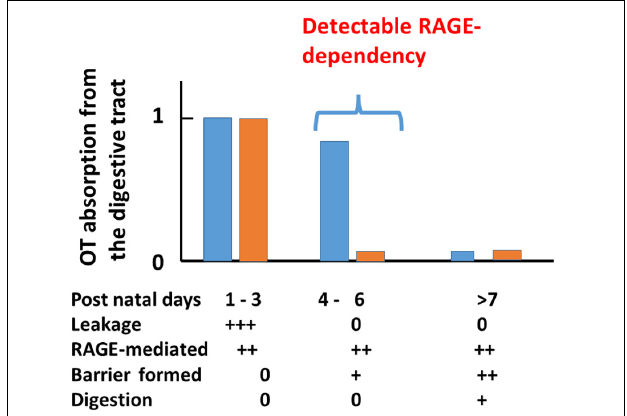
FIGURE 2 | A scheme for plasma OT (OT) concentrations in wild-type (blue) and receptor for advanced glycation end-product (RAGE) knockout (KO; orange) mouse pups after oral OT administration. Plasma OT levels in pups 10 min after oral administration of 1 µ g of OT/mouse (10 µ L). Blood samples were collected from the hearts of male and female pups on the indicated postnatal days (PNDs). Plasma OT levels are schematically illustrated as bars during three periods after birth. The three time periods (1–3, 4–6, and > 7 days) were classified by various factors. During PNDs 1–3, OT levels are equally high in both genotypes, owing to mainly OT leakage from the intestinal mucosa to body fluid where an intestinal barrier has not formed. During PNDs 4–6, in which OT leakage is dramatically decreased because an intestinal barrier has formed. Plasma OT is relatively high in wild-type pups but not in RAGE KO pups because RAGE-dependent OT transport mainly contributes to OT concentrations. During PNDs > 7, in wild-type pups, intestinal barrier and OT cleavage by digestion mask RAGE-dependent OT transport, which resulted in no apparent OT increases. Symbols (0, +, and ++) represent little to no permeability or presence to the highest levels in wild-type or RAGE KO mice. This figure is modified from Figure 3 by Higashida et al. (2017a).